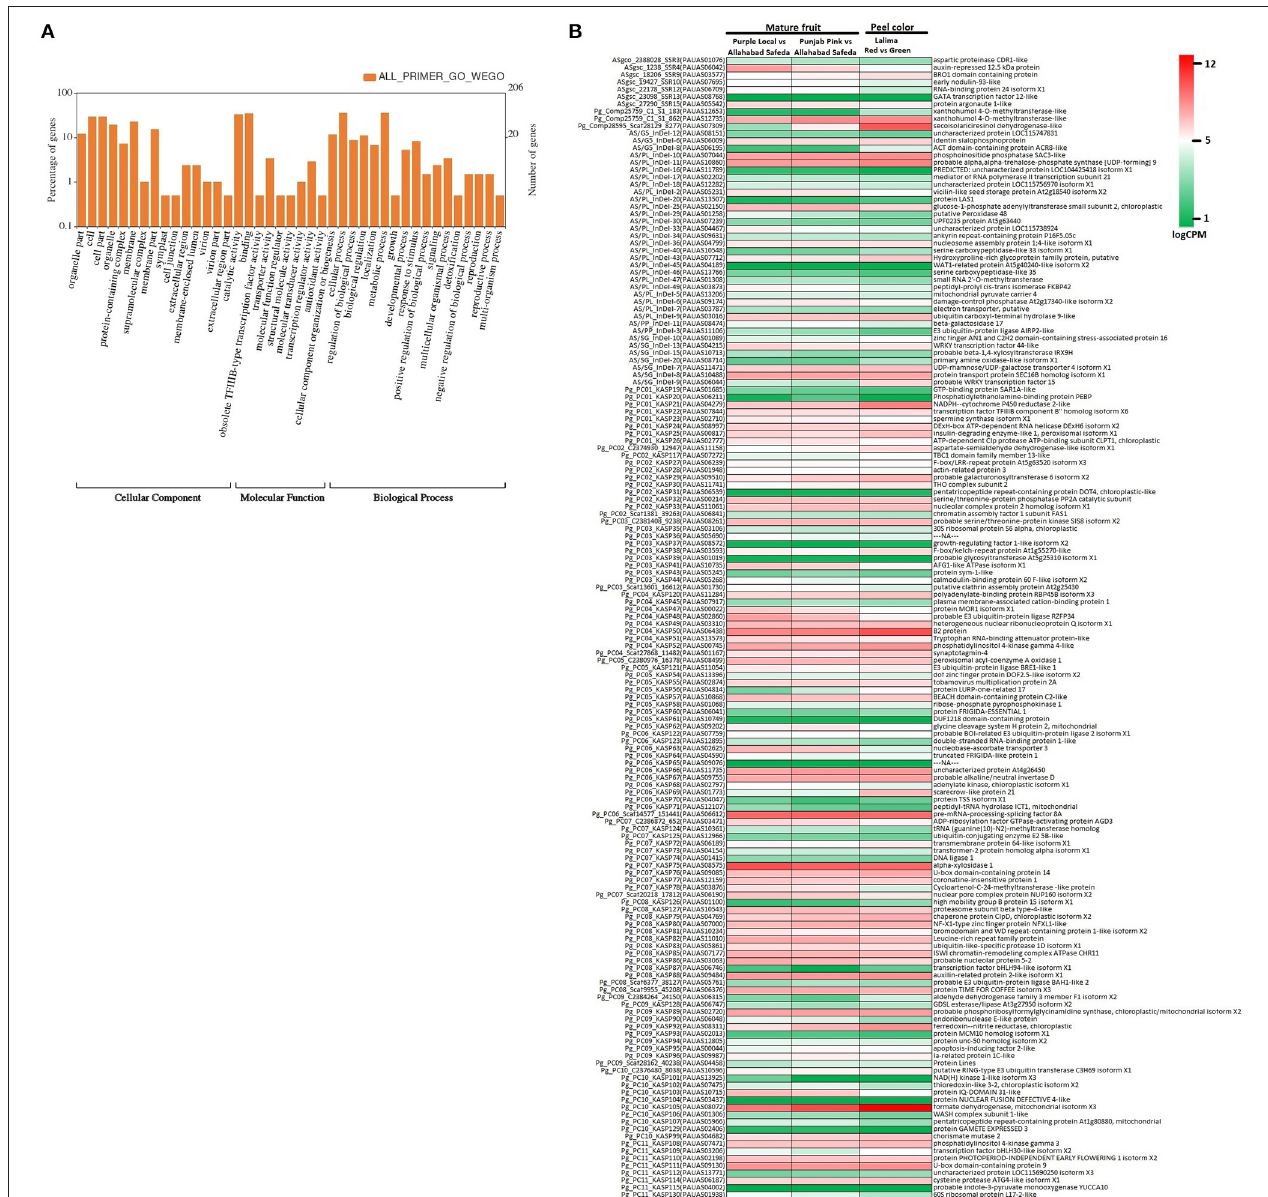
FIGURE 7 | Functional classification of genes harboring markers. (A) WEGO analysis shows functional classification based on cellular component, molecular function, and biological process. (B) Heat map of gene expression in colored vs. non-colored tissues viz. mature fruit of Purple Local vs. Allahabad Safeda, mature fruit of Punjab Pink vs. Allahabad Safeda, and red peel vs. green peel of Lalima.